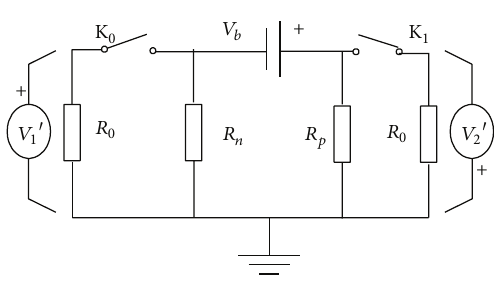
Figure 10: Calculation model of positive insulation resistance.